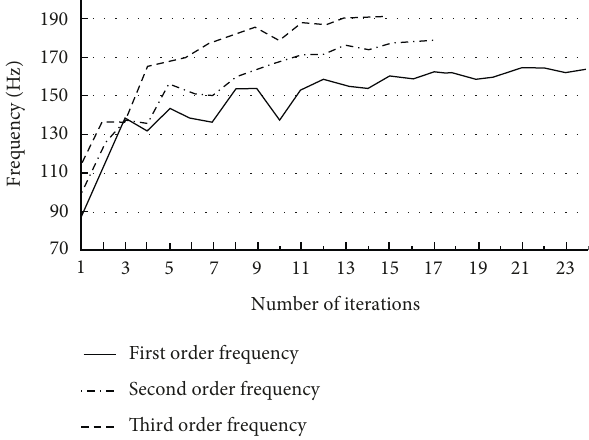
Figure 7: Dynamic load topology optimization iteration curve. Table 2: Analysis results after optimizing subobjectives